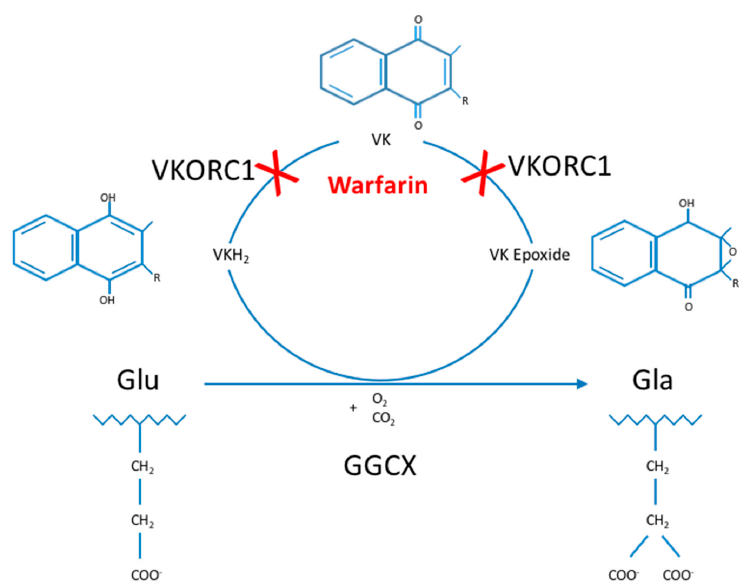
Figure 1. The Vitamin K cycle. Glu-residues are gamma-carboxylated by GGCX to Gla-residues, an enzymatic process using VKH 2 , O 2 and CO 2 as cofactors. During this process, VKH 2 is oxidized to VK epoxide, which is then reduced to VK and in a second reduction step to VKH 2 by VKORC1. Then, VKH 2 can be reused, the reason for which this process is called the VK cycle. Gamma-carboxylation is only performed in VKDP and is essential for their activation and downstream functioning in multiple biological processes, such as blood clotting, bone formation, inflammation and cell